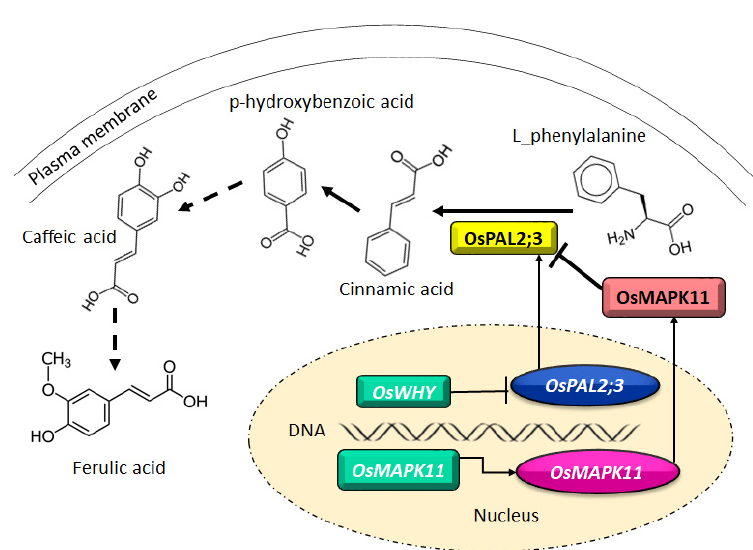
Figure 2. Schematic summary proposed by Fang et al. [35] describing OsMYB57 as a positive regulator of OsPAL2;3 gene expression, since it is involved in the transcriptional regulation of OsMAPK11 gene expression. OsMAPK11 protein then interacts with OsPAL2;3 to regulate its activity in the phenylpropanoid pathway. OsWHY transcription factor represses the transcription of OsPAL2;3